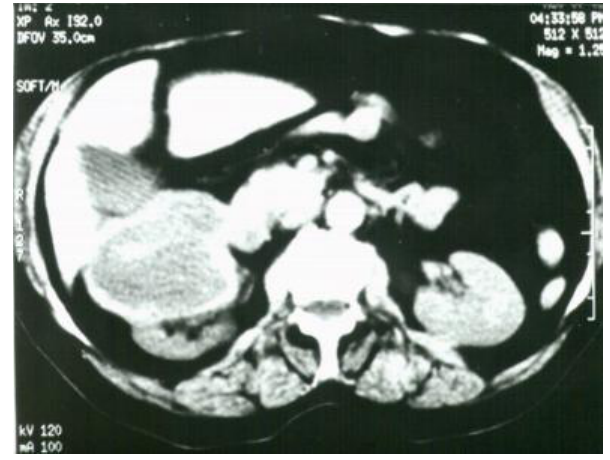
FIGURE 1. Computed tomography: Right renal mass 4/5 cm, with central necrosis and heterogeneous enhancement by contrast